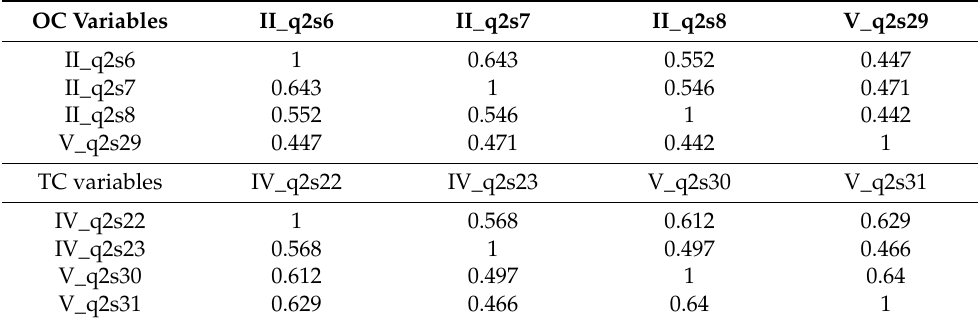
Table 6. Correlation matrices for OC and TC